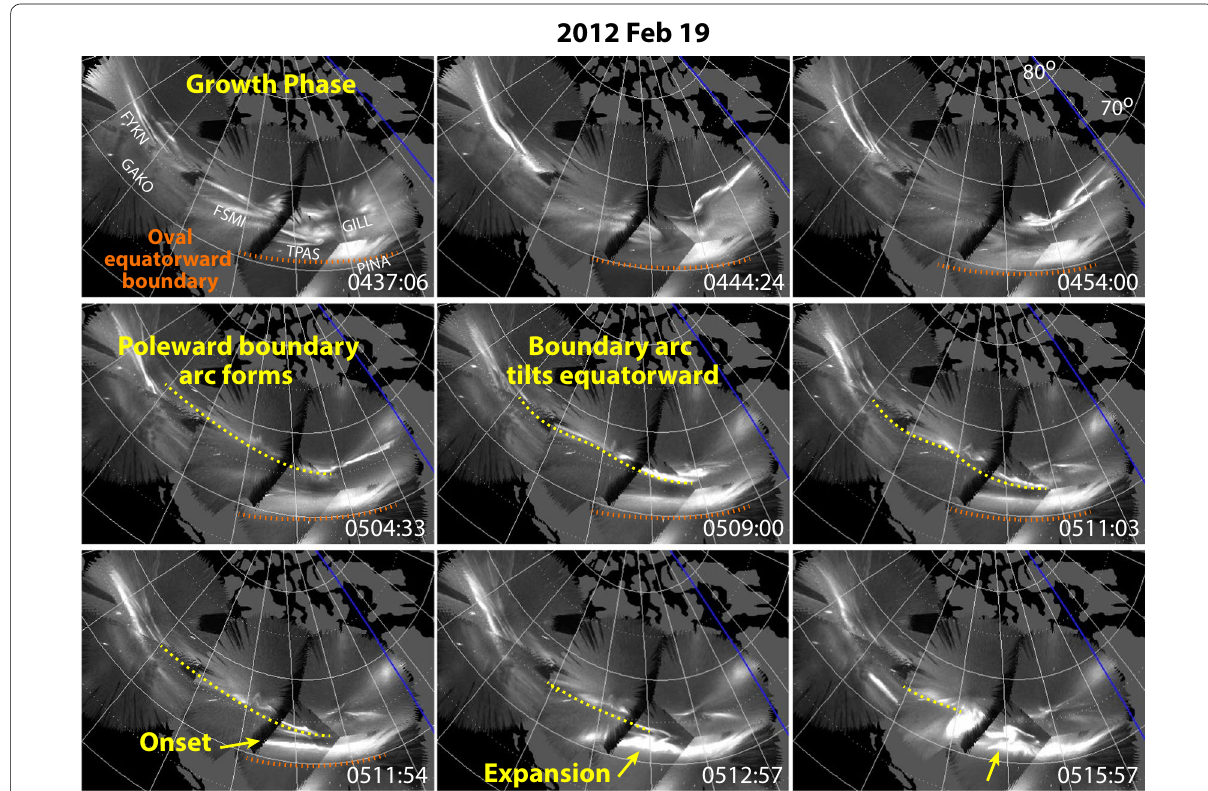
Fig. 1 Representative mosaics of images on 19 February 2012 from the THEMIS ASIs over North America showing the motion of a tilted streamer as it extended to a substorm onset in the equatorward portion of the auroral oval. UT is each mosaic is given in the lower right of each panel, longi‑ tude lines are separated by 1 h in MLT, and ASI stations used in the mosaics are identified in the upper left